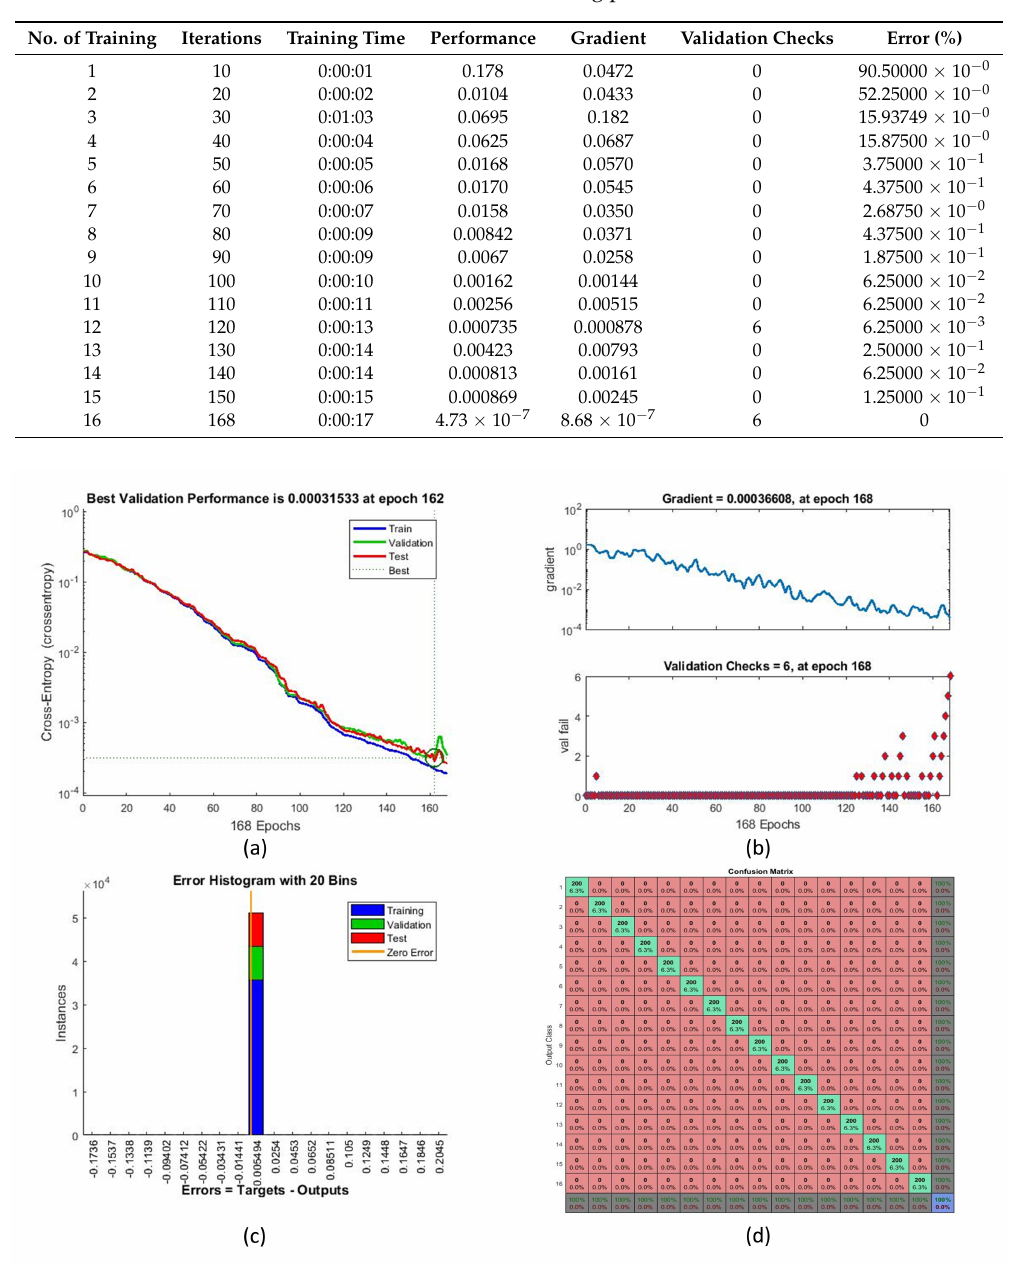
Figure 9. Neural network training performance parameters: ( a ) cross-entropy, ( b ) training state, ( c ) error histogram, and ( d ) overall confusion